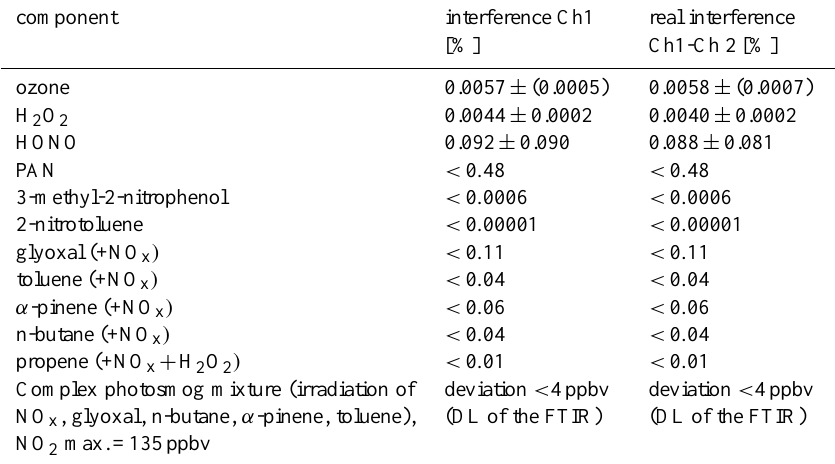
Table 3. Summary of the interferences tested for the NO 2 -LOPAP instrument. component